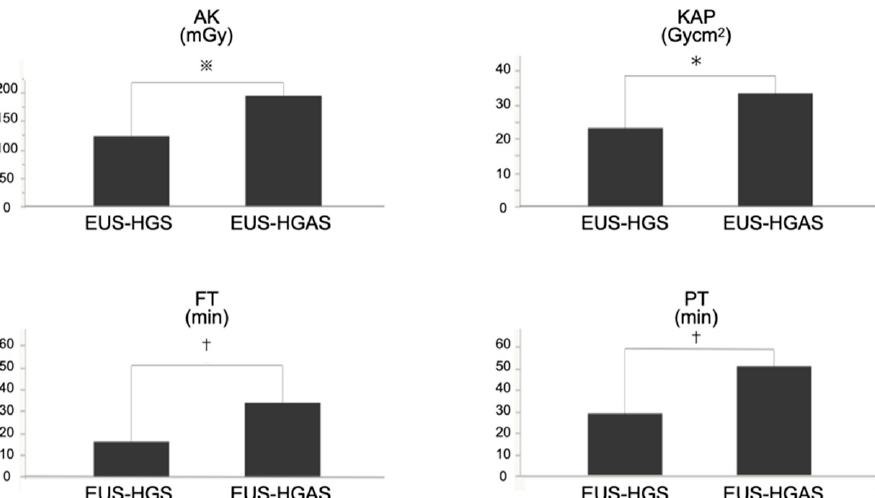
Figure 4. The radiation dose (AK/KAP) and time factors (FT/PT) in the EUS-HGS and EUS-HGAS groups. The median AK, KAP, FT, and PT were higher in the EUS-HGAS group than in the EUS-HGS group. ( ※ p = 0.0014, ∗ p = 0.0006, † p < 0.0001). AK: air kerma, KAP: kerma–area product, FT: fluoroscopy time, PT: procedure time, EUS-HGS: endoscopic ultrasound-guided hepaticogastrostomy, EUS-HGAS: EUS-guided antegrade stenting (EUS-AS) combined with hepaticogastrostomy.